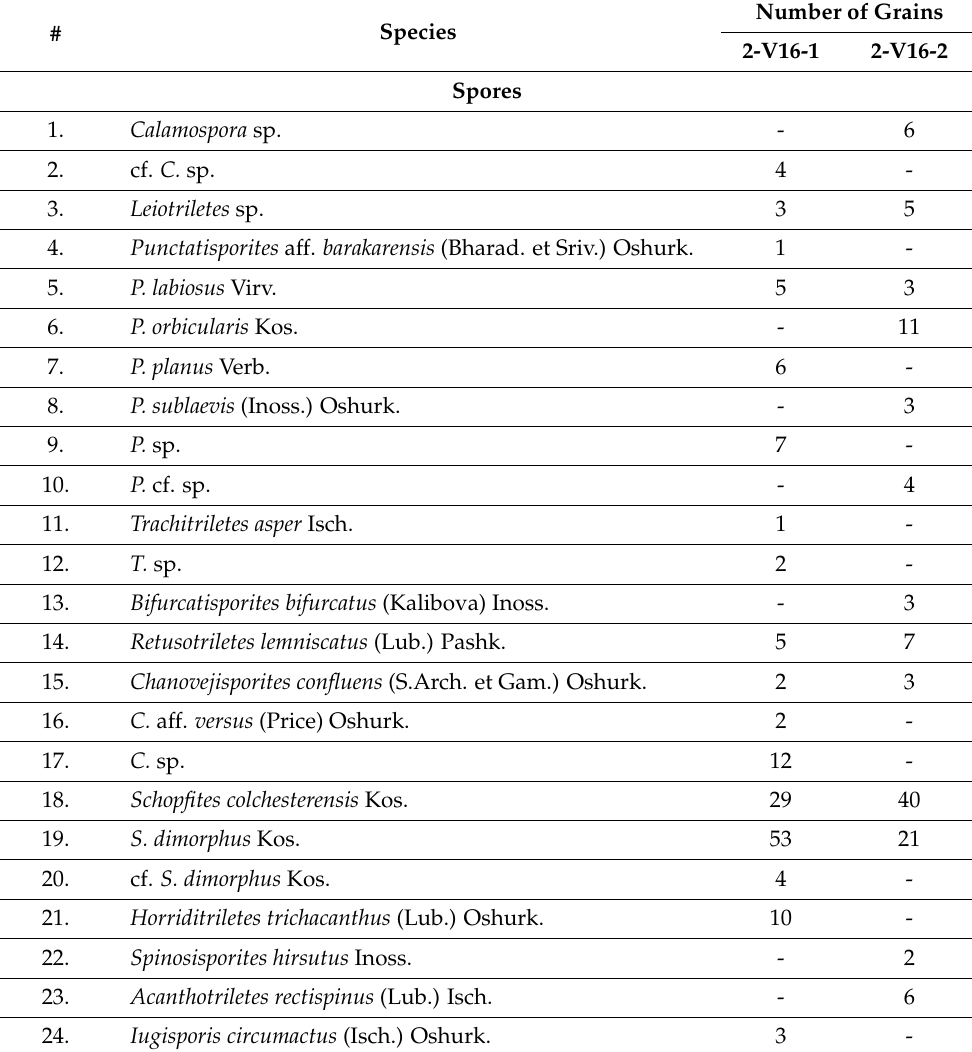
Table 1. List of spore and pollen from studied